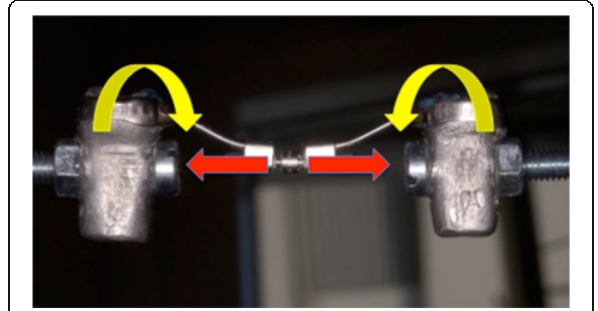
Fig. 12 Two-arm RPEs: bending moment generated on the vertical plane